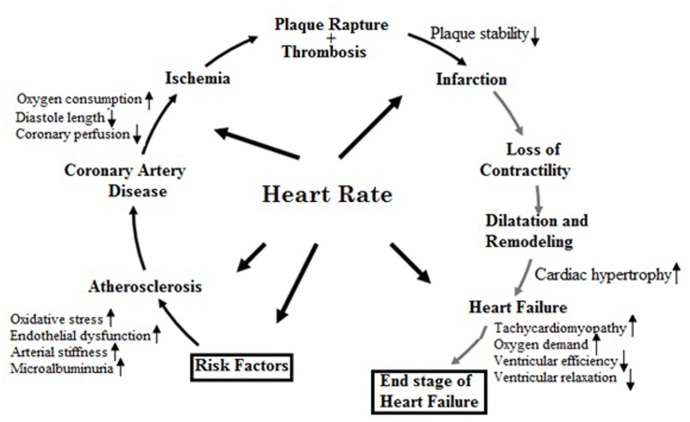
Pathophysiological effects of heart rate on the cardiovascular disease continuum (Adapted from Custodis et al., 2013 with permission).